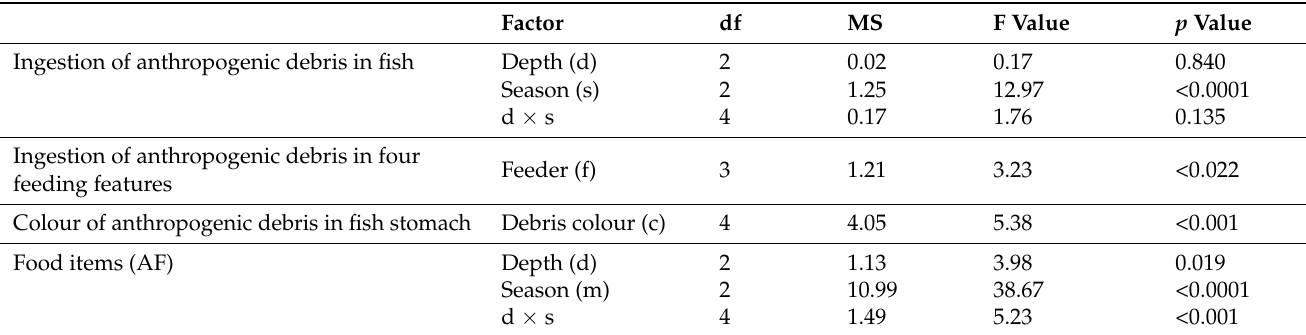
Table 3. Results of analysis of variance on the number of food types and ingestion of anthropogenic debris in 34 fish species by depth and season in addition to feeding features (df = degrees of freedom, MS = mean sum of squares).